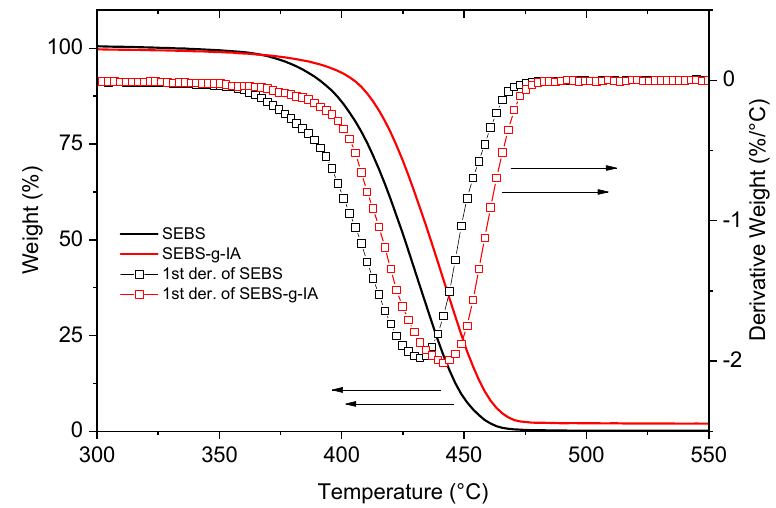
Figure 5. Thermogravimetric analyses of SEBS and SEBS-g-IA and the first derivative curves.